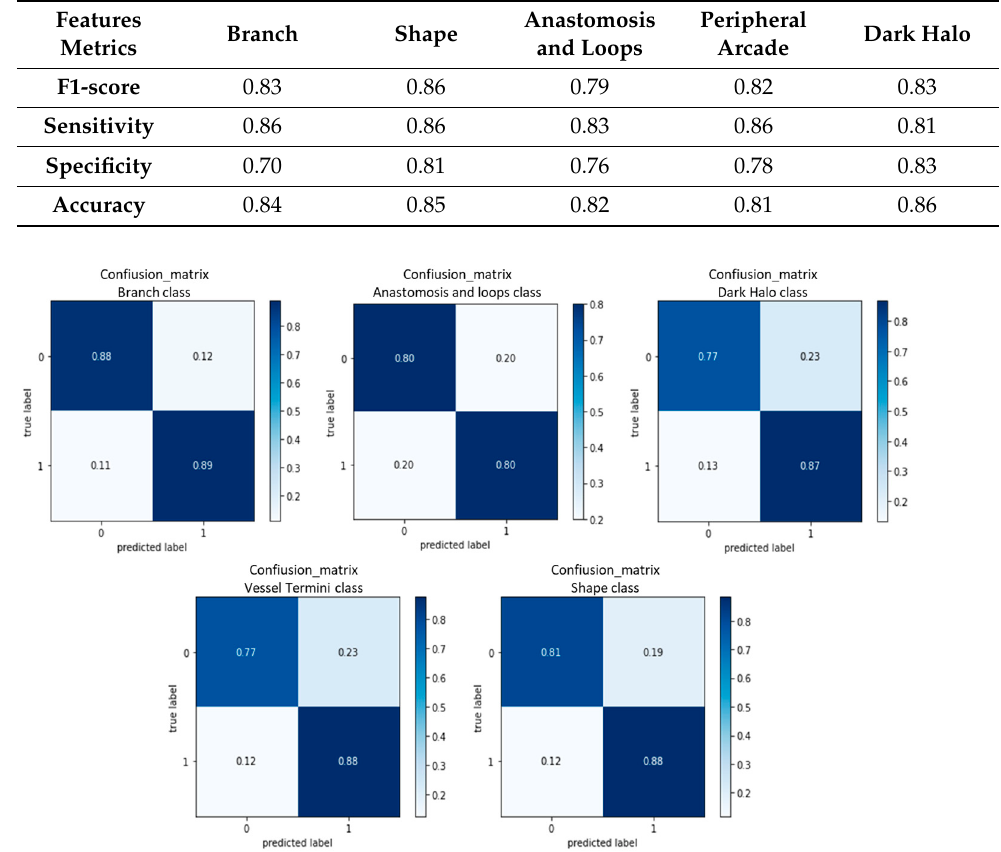
Figure 9. Representative confusion matrices of 5-category binary classification (Table 1 shows the number of images falling into each category). These matrices show the average performance across di ff erent folds. Table 3. Classi fi cation metrics for fi ve classi fi er models.